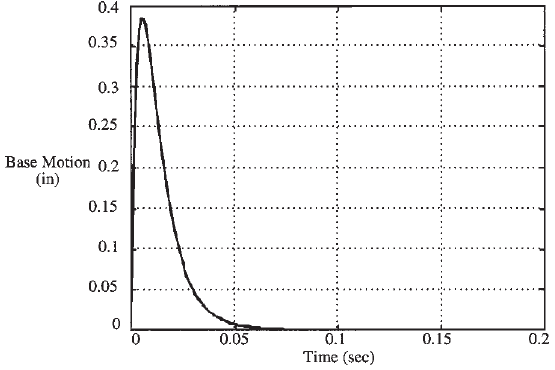
Fig. 3. Transient base displacement excitation.